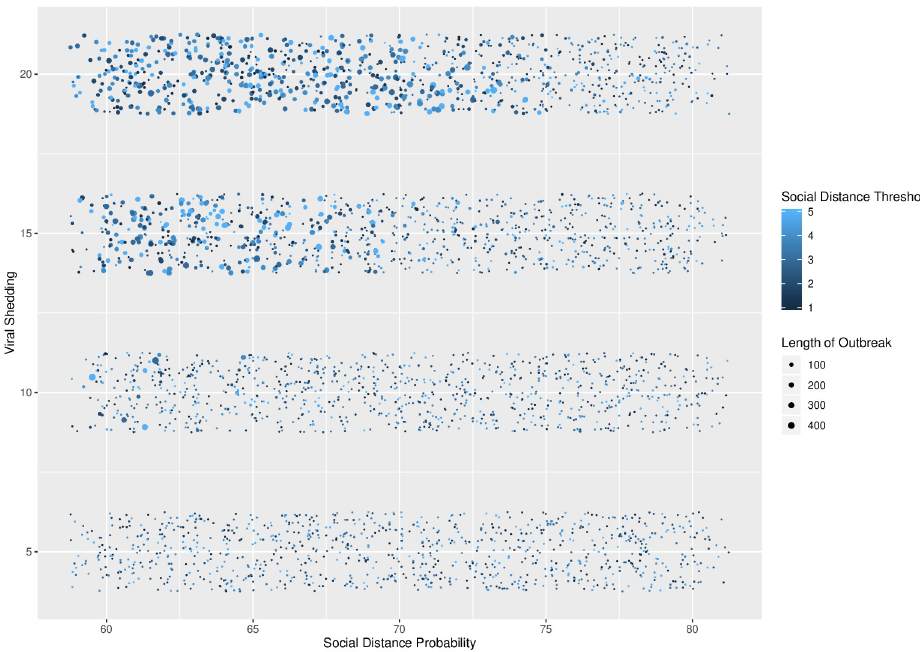
Fig 7. Social distance probability and viral shedding. Social distance probability vs. viral shedding, with social distance threshold and length of epidemic indicated by color and size. Longer outbreaks occur with low social distance probability and high viral shedding rates.